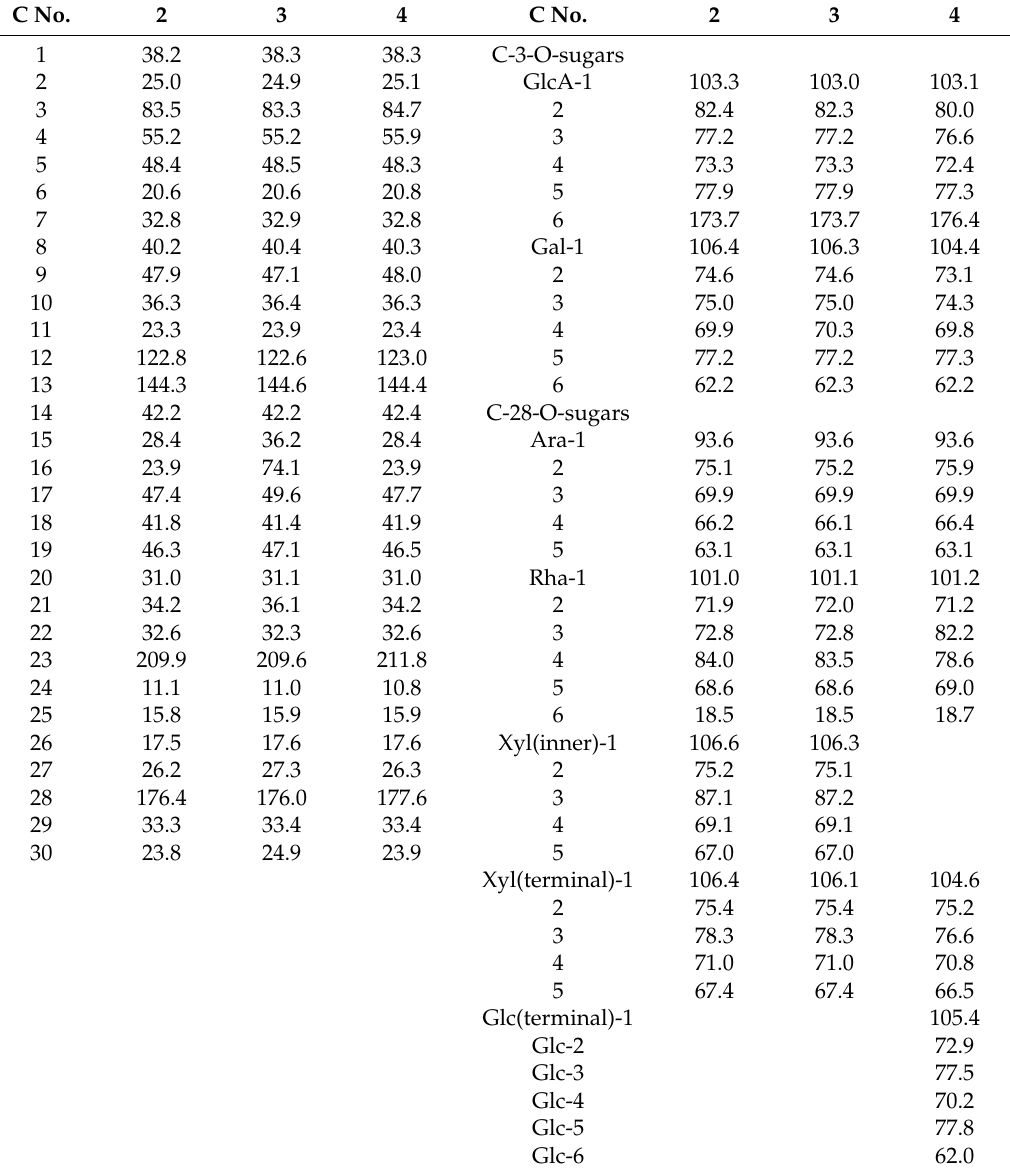
Table 2. The 13 C-NMR data of compound 2 – 4 in C 5 D 5